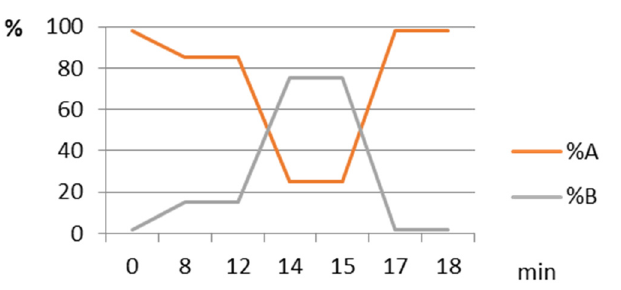
Figure 3. The gradient used in HPLC analysis. A: acetonitrile: H 2 O (9: 1, w / w ), B: ethyl acetate. All operations were carried out in reduced light, avoiding the samples’ exposure to more than 40 ◦